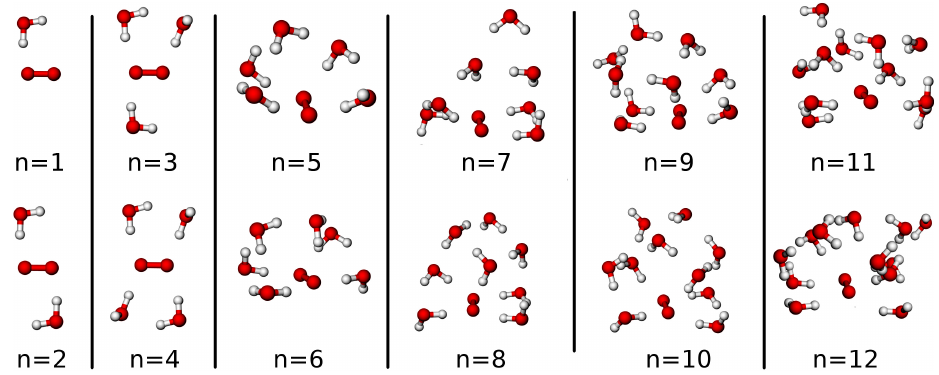
( H 2 O ) n clusters, n = 1 − 12. The O − Fig. 3. Structures of the most stable O − ions are always found inside, but near the surface of the clusters. 2 2 The solvent water adopts a clear shell-like structure, shown in Fig. 5. The charge on the central ion is partially delocalized, converging at ca. 0.80 e . See also Fig. 6.